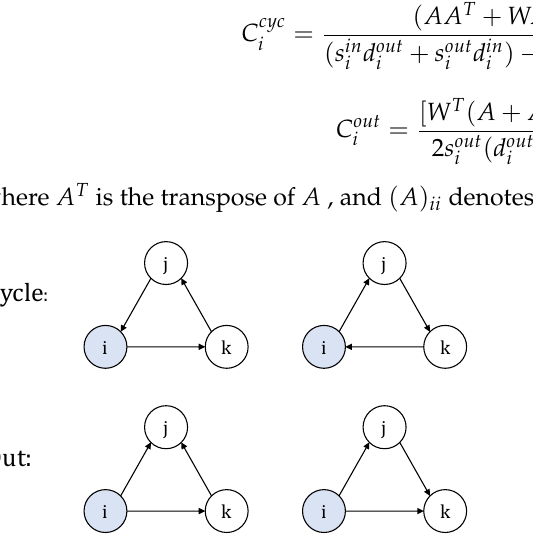
Figure 1. Schematic diagram of the two types of